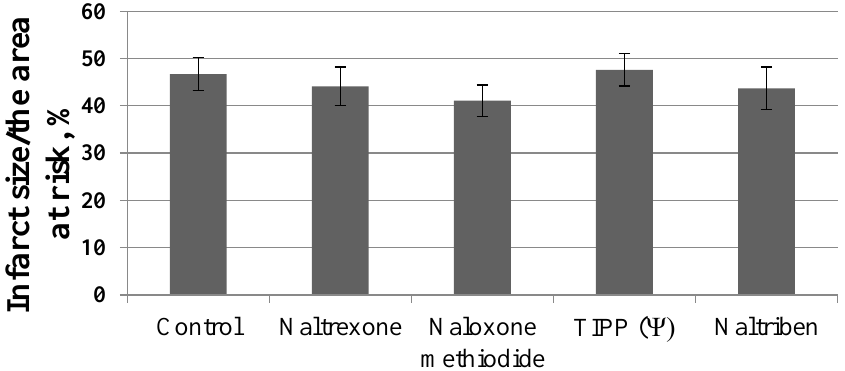
Figure 1. Effect of opioid receptor antagonists on the infarct size/area at risk ratio ( Y -axis). Data represent the means ± SEM. Each study group included 12 rats. The selective δ 2 opioid receptor agonist deltorphin II decreased the infarct size by 37% (Figure 2).